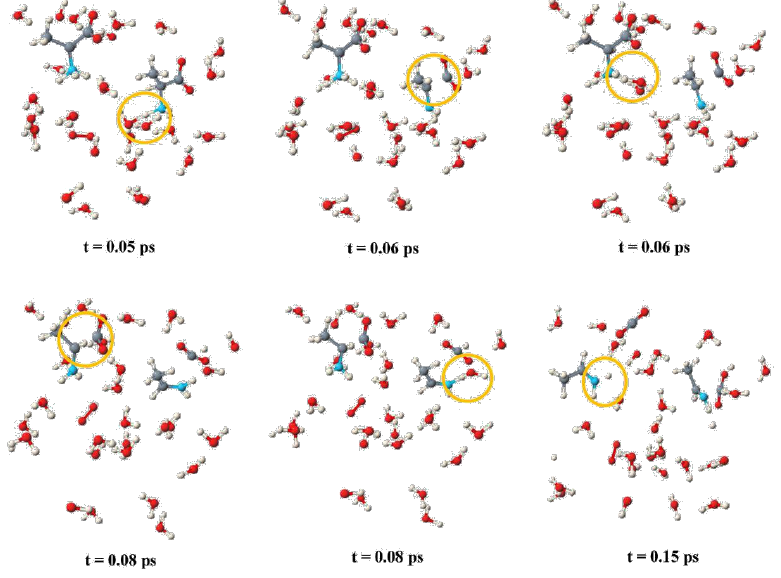
Figure 2. The anodic reaction of two alanine zwitterions as observed in the Car – Parrinello molecular dynamics (CPMD) simulations. The regions where reactions occur are marked with orange circles. The reaction pathway is explained in Figure